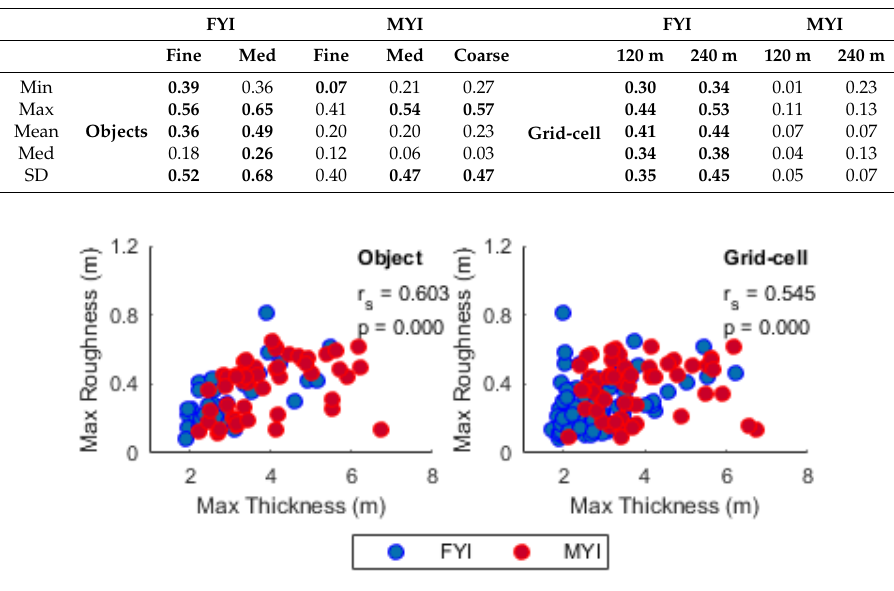
Figure 12. Scatter plots of maximum roughness as a function of maximum thickness at the medium scale using object ( left ) and 240 m grid-cell ( right ) aggregation approaches. Spearman correlation coefficients (r s ) and corresponding p -values are shown for pooled FYI and MYI